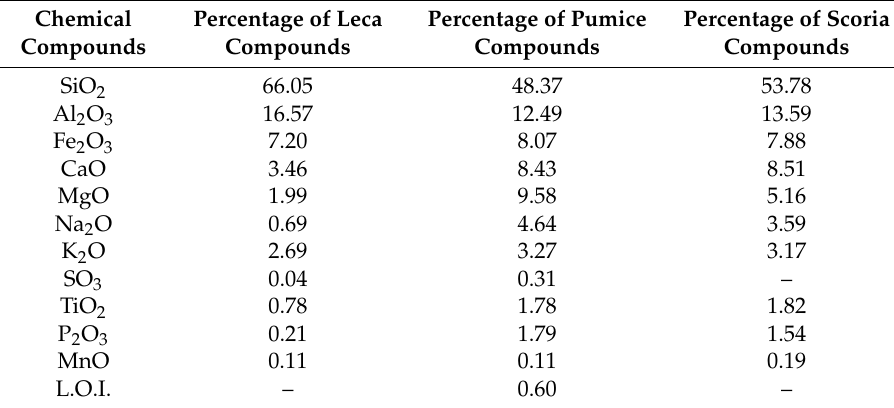
Table 5. Chemical properties of lightweight aggregates used.